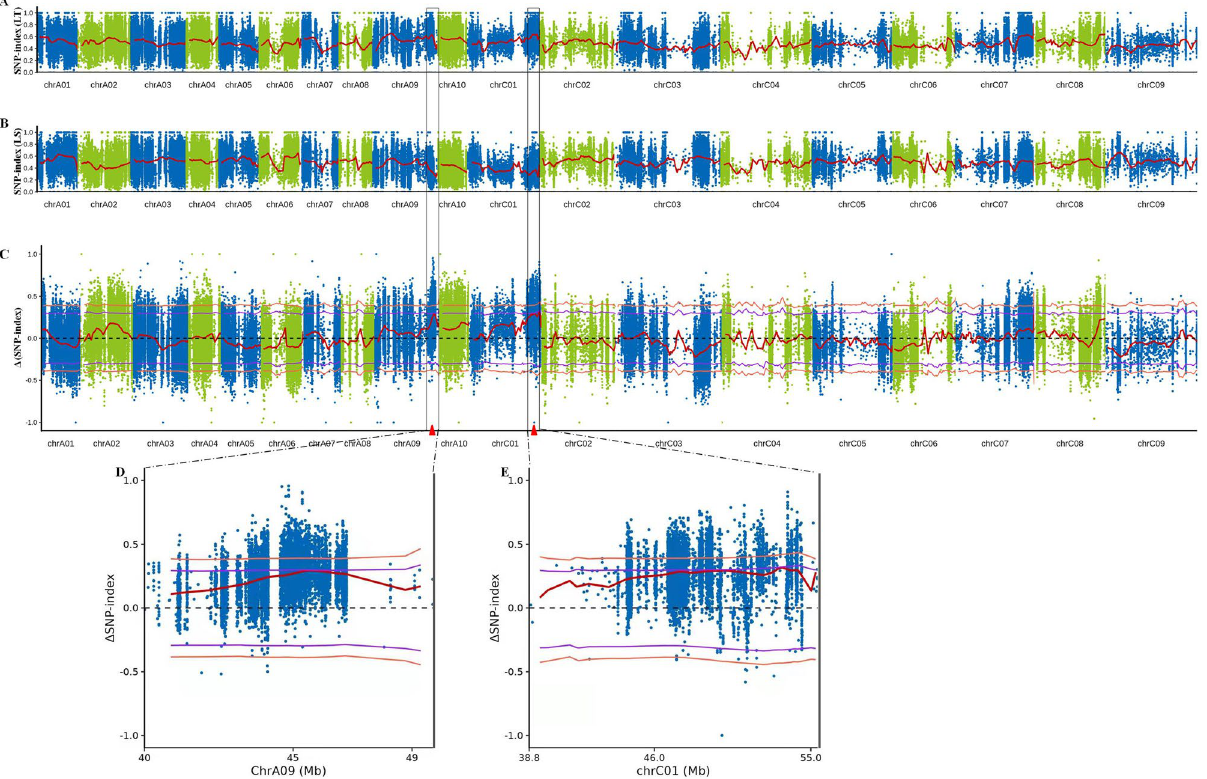
Figure 2. Identification of LTG QTL in F 2 populations by QTL-seq. ( A , B , and C ) represent the SNP-index plots of LT bulk and LS bulk, and the Δ(SNP-index) plot of 19 rapeseed chromosomes from QTL-seq analysis, respectively. Δ(SNP-index) plot with statistical confidence interval under the null hypothesis of no QTL (purple, P < 0.05; orange, P < 0.01). ( D )and ( E ) represent the significant genomic regions of 40.00–49.73 Mb on chromosome A09 and 38.90–55.38 Mb on chromosome C01 identified for LTG, respectively. The X-axis represents the chromosomes of rapeseed, and Y-axis represents the